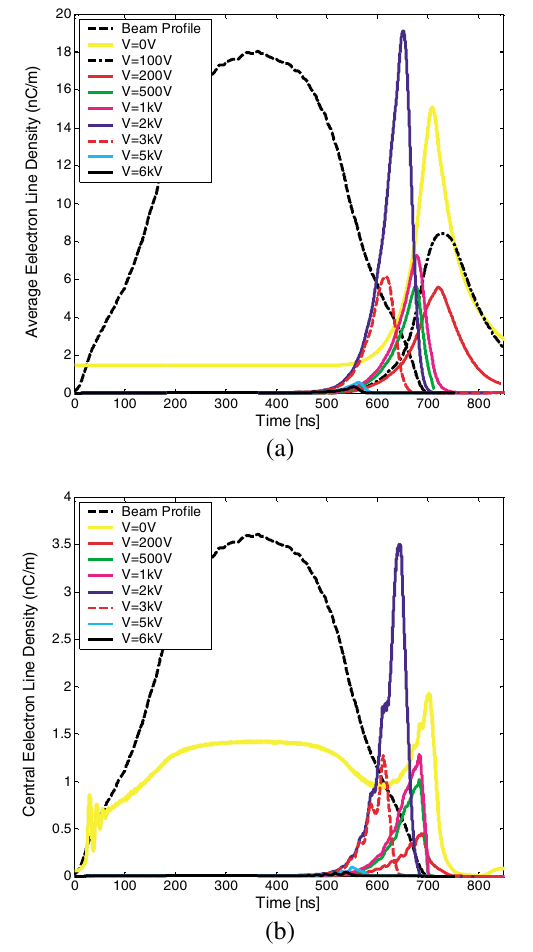
FIG. 5. (Color) Electron cloud buildup with various clearing voltages in the SNS’s drift region. (a) The electron cloud line density inside the vacuum chamber, and (b) inside the